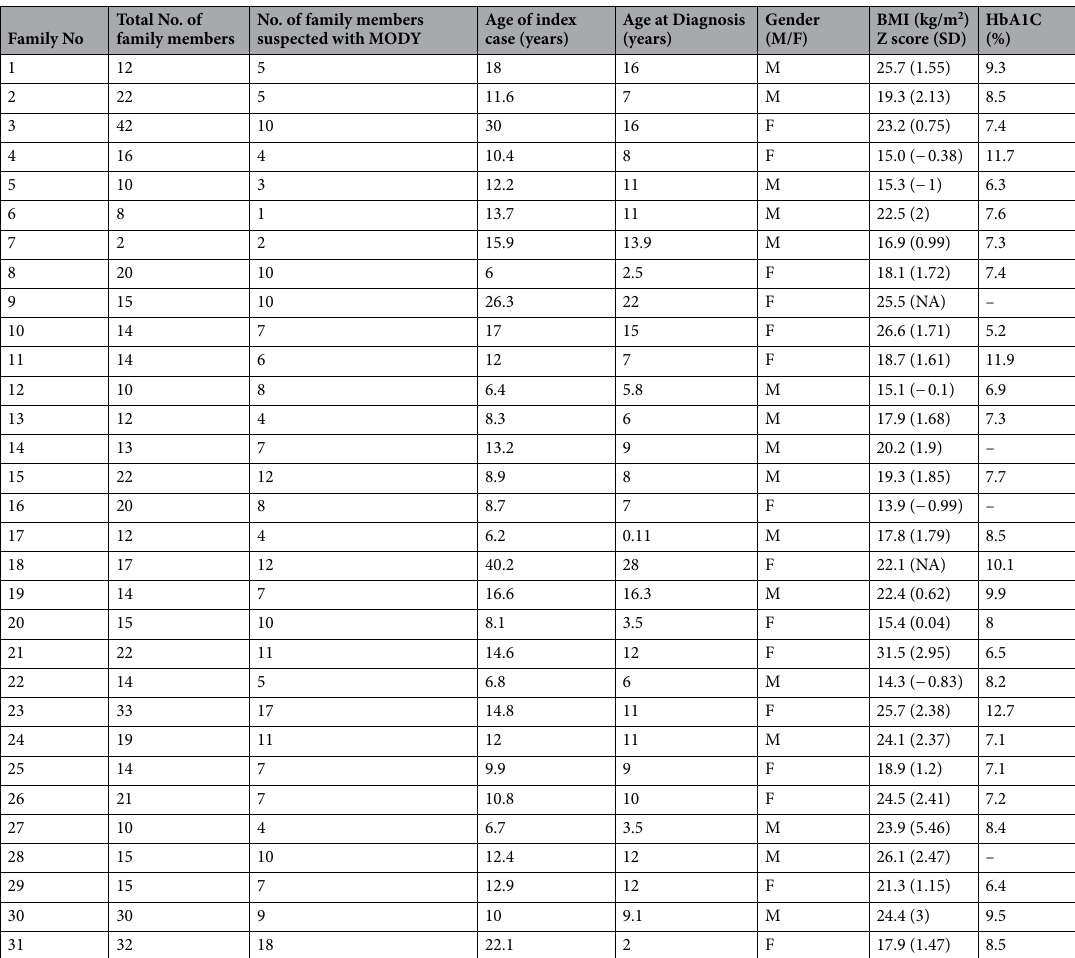
Table 1. Clinical and genetic characterization of index cases of MODY families. BMI Body mass index, HbA1C Hemoglobin